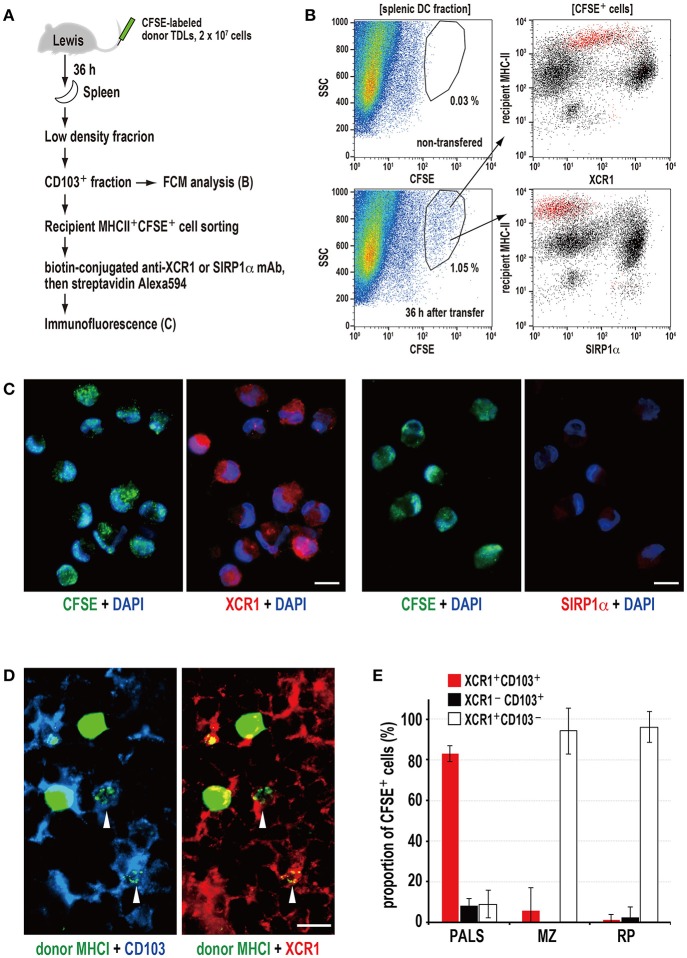
Phagocytosis of donor MHCI fragments and phenotype of phagocytic DCs in the spleen. (A) Experimental protocol for identifying DCs that phagocytosed donor cells. (B) Three-color FCM analysis of magnetically isolated CD103+ DC fraction of the recipient spleen 36 h after CFSE-labeled thoracic duct lymphocyte (TDL) injection for CFSE, XCR1, or SIRP1α, and recipient MHCII. XCR1+SIRP1α−CD103+MHCIIhigh DCs expressing CFSE+ signals (red dots) were detected within the gated fraction (1.05%) of the SSC vs. CFSE plot. A representative data of 4 individual experiments. (C) Two-color immunofluorescent staining of cytosmears of sorted CD103+recipient MHCIIhighCFSE+ cells for DAPI (DNA stain, blue), and XCRI or SIRP1α (red). CFSE+ donor cell fragments (green) were observed in the cytoplasm of XCR1+SIRP1α− DCs but not XCR1−SIRP1α+ DCs, indicating phagocytosis. Scale bar = 10 μm. (D) Three-color immunofluorescent staining of the PALS cryosections for donor MHCI (green), CD103 (blue), and XCR1 (red). The arrowheads indicate XCR1+CD103+ DCs with phagocytosed donor MHCI+ fragments. Scale bar = 10 μm. (E) The subset and ratio of CFSE+ phagocytic cells in different splenic areas. In the PALS, XCR1+CD103+ DCs accounted for more than 80% in CFSE+ phagocytic cells (mean ± SD, n = 4 rats each). In contrast, more than 90% phagocytic cells in the marginal zone (MZ) and red pulp (RP) were XCR1+CD103− non-DCs.